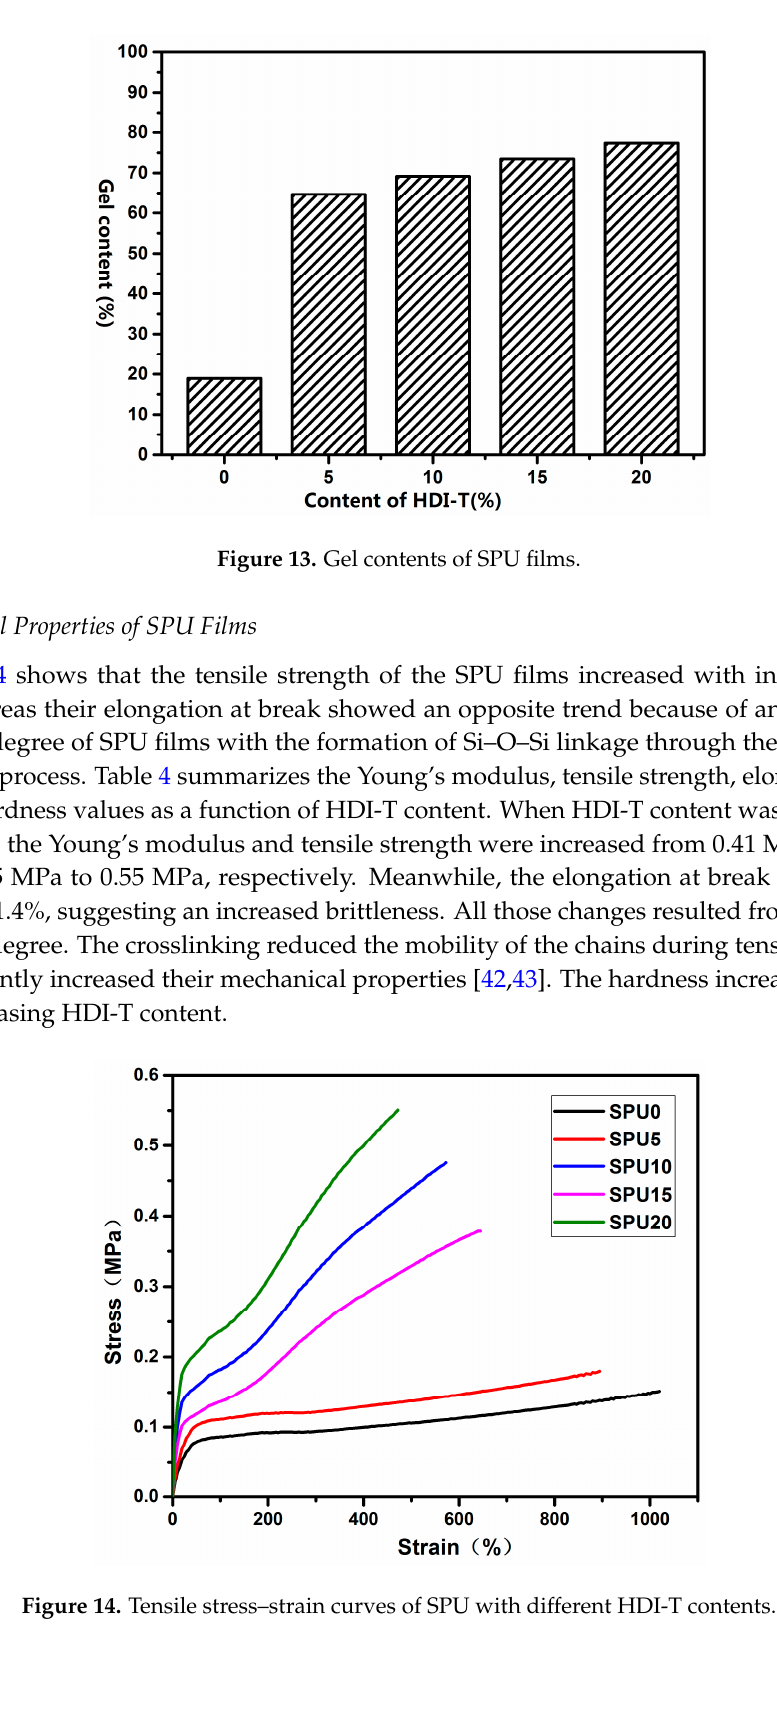
Figure 14. Tensile stress–strain curves of SPU with different HDI-T contents.